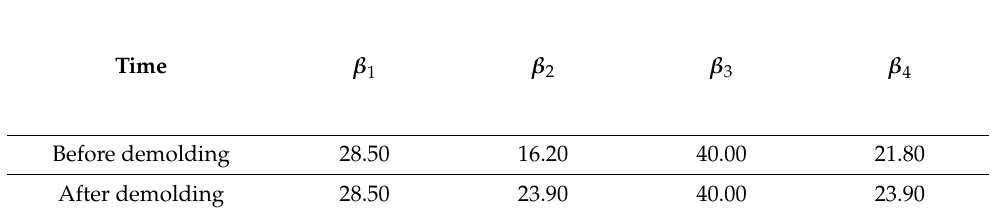
Table 2. Exothermic coefficients of box girder surface unit: kJ/ ( m 2 · h · ◦ C )